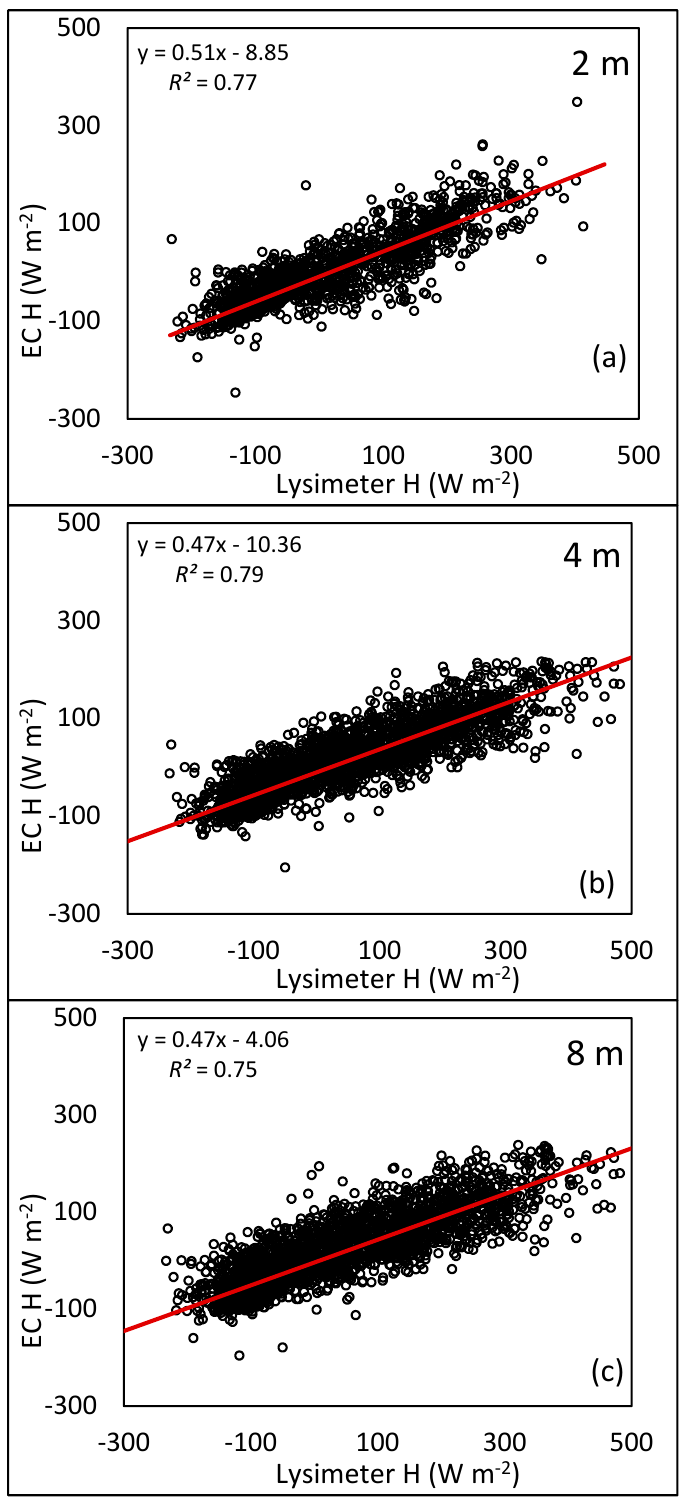
Figure 4. Sensible heat flux (H) from the three eddy covariance (EC H) systems regressed against H calculated from the lysimeter for systems installed at 2.5 ( a ), 4.5 ( b ), and 8.5 m ( c ).